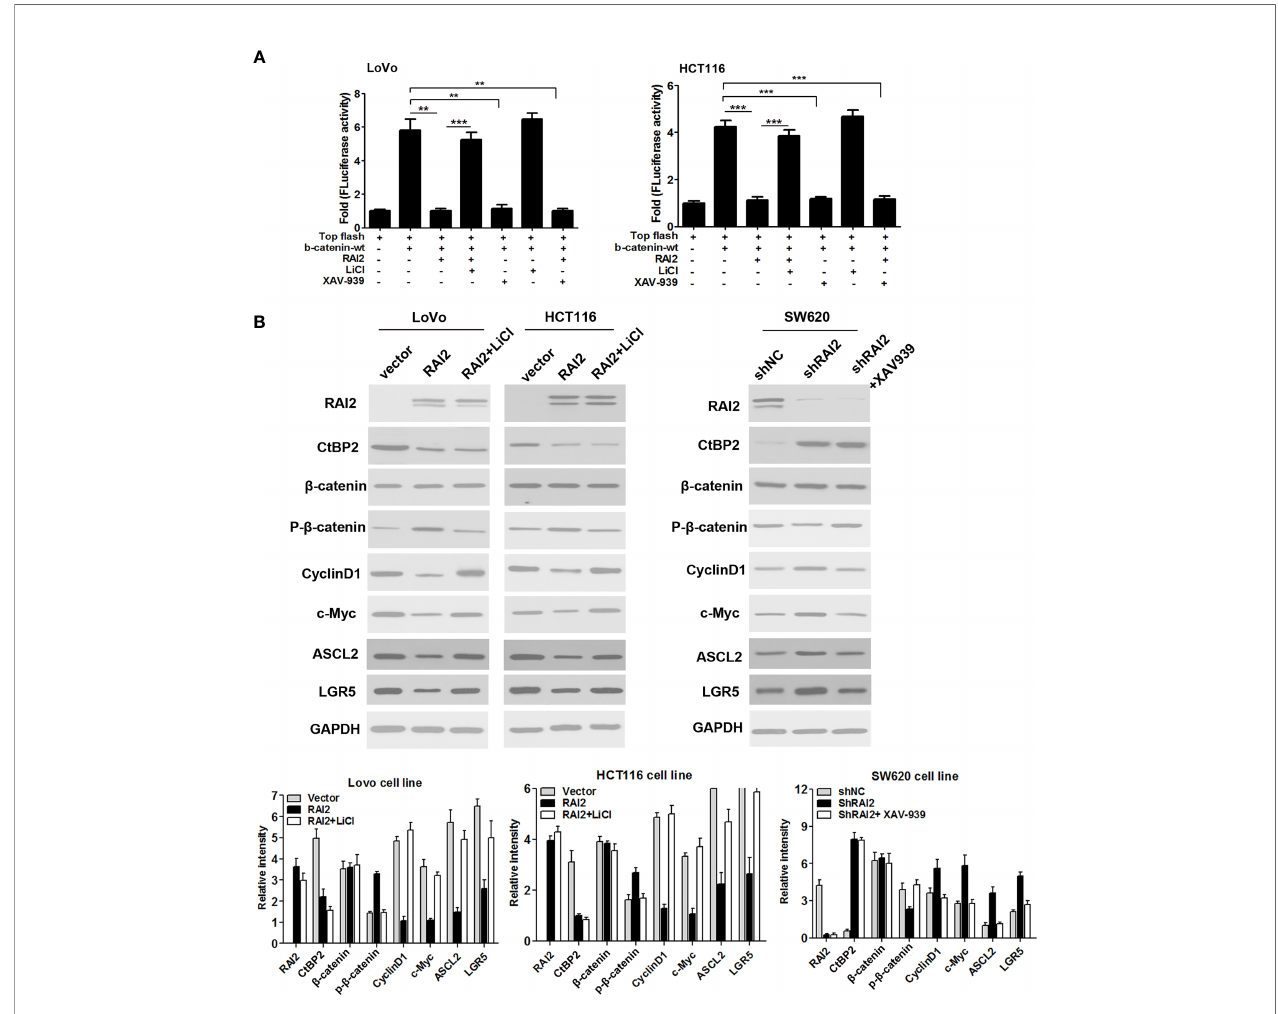
FIGURE 2 | RAI2 suppressed activation of Wnt/ b -catenin signaling pathway. (A) Dual-Luciferase reporter assay analyzed the effect of RAI2 plasmid transfection on wild-type b -catenin ( b -catenin-wt)-induced activation of Wnt/ b -catenin signaling in LoVo/HCT116 cells with or without LiCl/XAV939 addition (the concentrations of LiCl and XAV939 were 20mM and 10 µM respectively). LiCl and XAV939 were agonist and antagonist of Wnt/ b -catenin signaling respectively. (B) Western blot analysis of RAI2, b -catenin, phosphorylated b -catenin (p- b -catenin) CtBP2 and the Wnt/ b -catenin signaling target genes c-Myc, cylinD1, ASCL2, and LGR5 expression in LoVo/HCT116 cells with RAI2/empty vector transfection and RAI2-transfected cells with LiCl addition (20mM). The same experiment was also performed in shNC/shRAI2-transfected SW620 cells and shRAI2-transfected SW620 cells with XAV939 addition (10 µM). p-values: **<0.01;